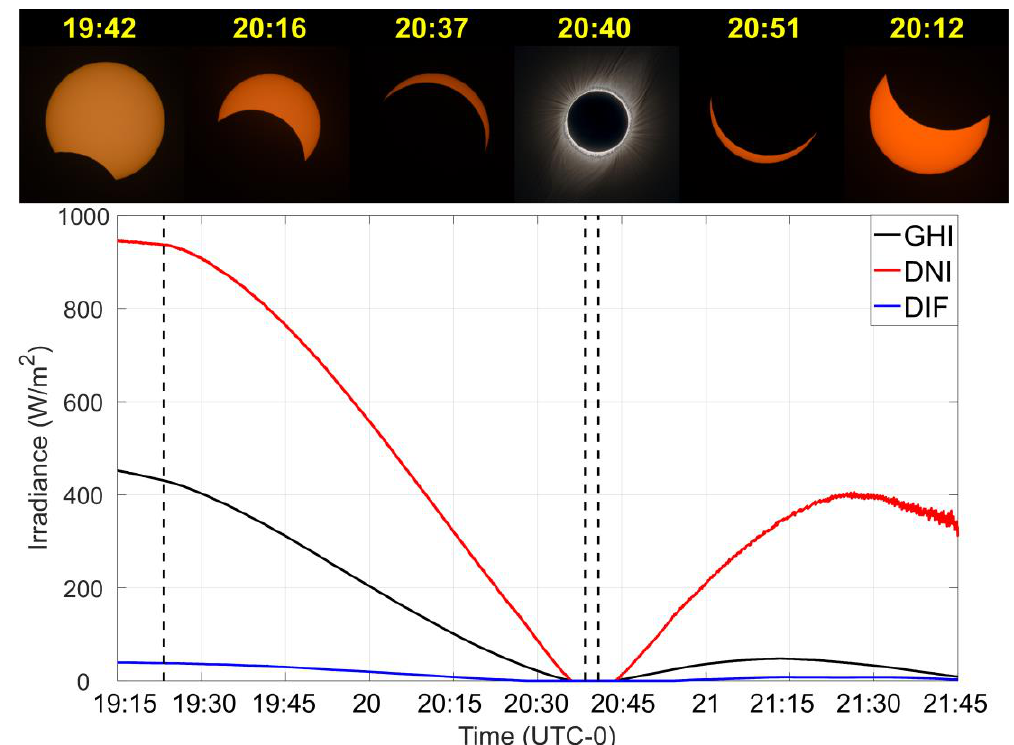
Figure 11. Detailed time series for the total eclipse at the SHA station, along with photographic record of the event. Vertical dashed lines mark contact points C1 through C3 according to astronomical algorithm.